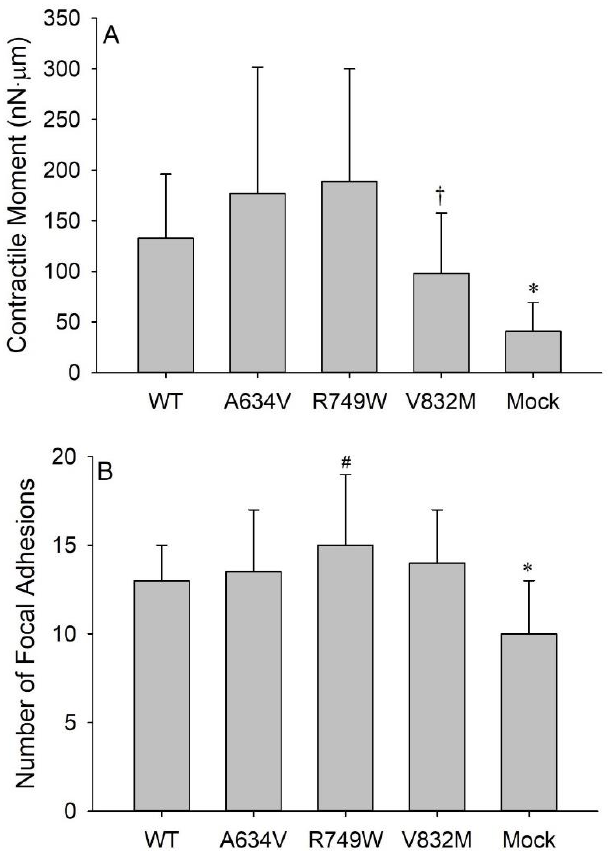
Figure 3. Impact of E-cadherin variants on the contractile moment and focal adhesion number. ( A ) Median values of time-averaged contractile moments of WT, A634V, R749W, V832M, and Mock AGS cells cultured on the combination of Fibronectin and Vitronectin micropatterns. The Mock cells exhibit a significantly smaller contractile moment than the other cell types (* p < 0.05), whereas the V832M cells exhibit a significantly smaller contractile moment than the A634V cells ( † p < 0.05). ( B ) Median values of the number of focal adhesions (FAs) of WT, A634V, V832M, R749W, and Mock AGS cells cultured on the combination of Fibronectin and Vitronectin micropatterns. The Mock cells exhibit a significantly smaller number of FAs than the other cell types (* p < 0.05), whereas the R749W cells exhibit a significantly greater number of FAs than the WT cells ( # p < 0.05). Graphs represent median ± MAD.